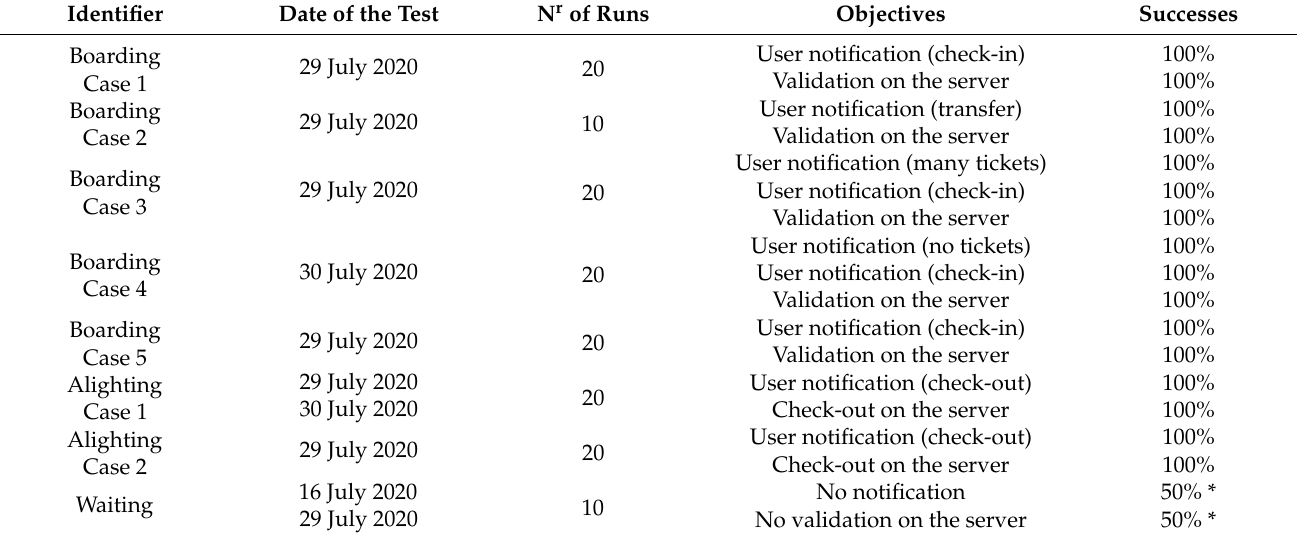
Table 4. Main results of the different testing scenarios in terms of successful